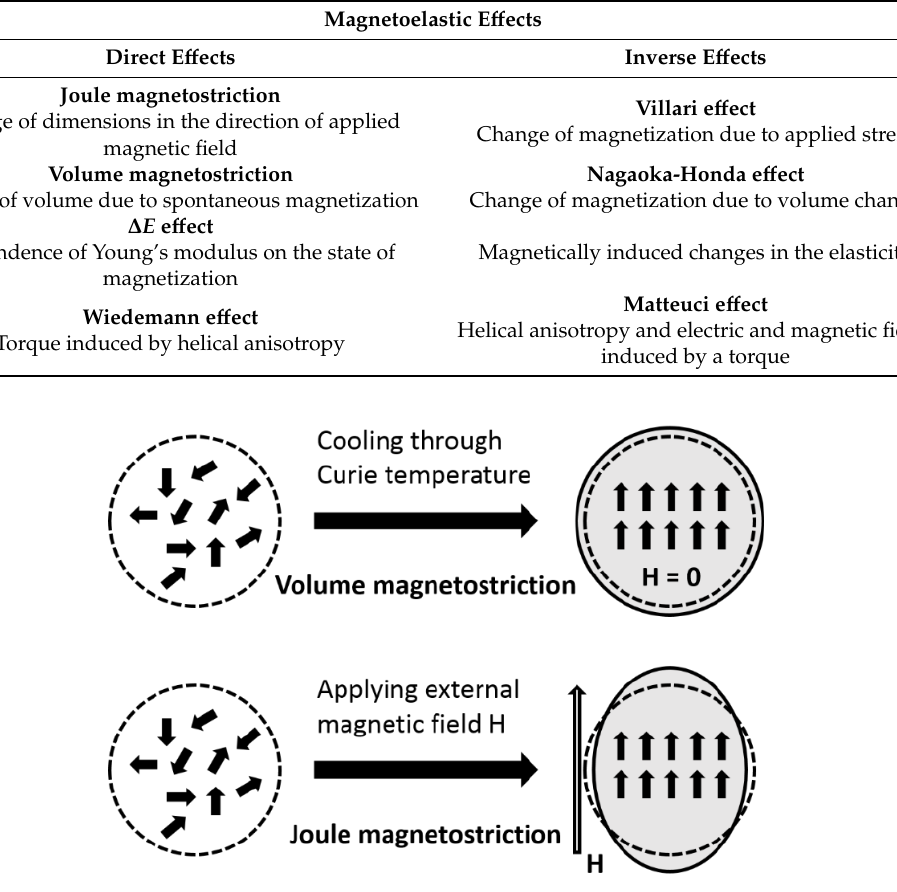
Figure 2. Illustration of volume and Joule magnetostriction of a spherical sample. Table 3. Classifications of magnetoelastic effects.